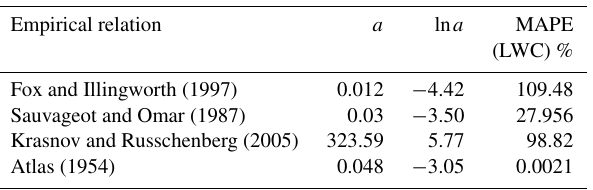
Table 7. Error in retrieved LWC for fixed a when LWP is not as- similated.